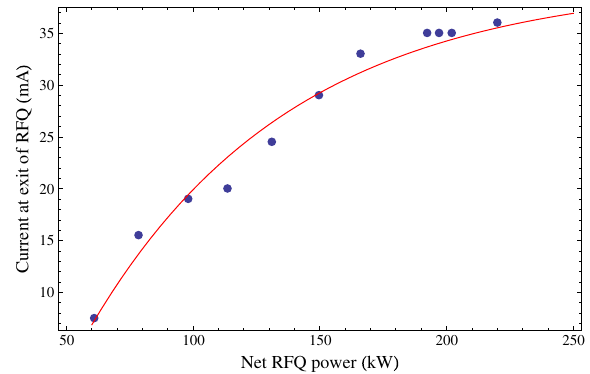
FIG. 7. The beam current (blue circle) measured with an oscillocope connected to a toroid installed at the end of the RFQ as a function of input power. The input current is 60 mA and the maximum transmission occurs above 200